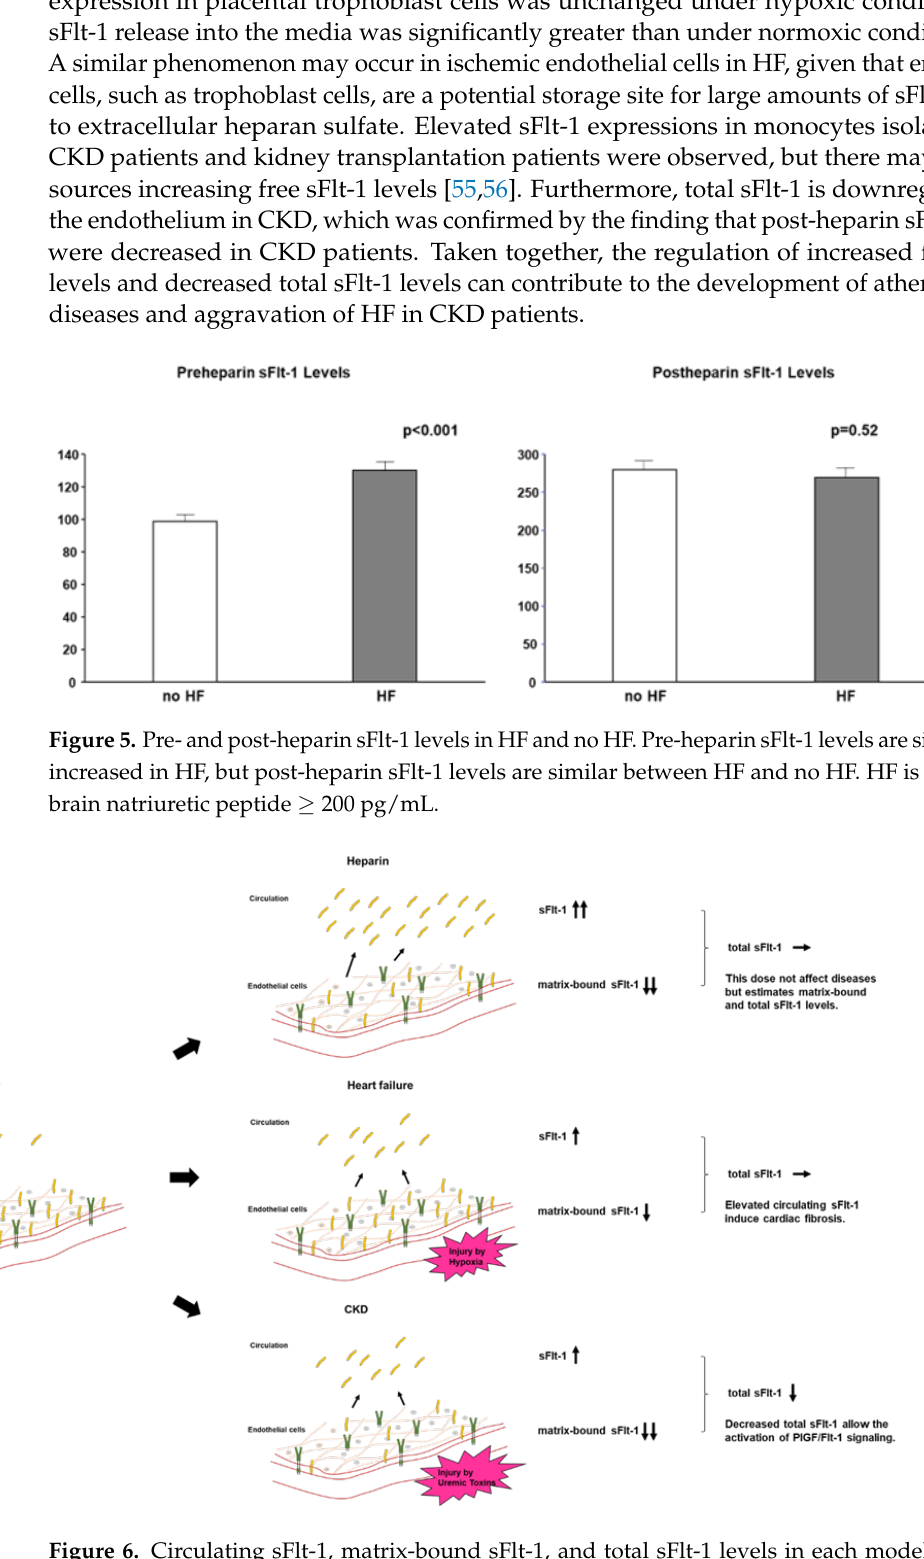
Figure 6. Circulating sFlt-1, matrix-bound sFlt-1, and total sFlt-1 levels in each model. Heparin infusion releases matrix-bound sFlt-1 into the circulation by displacing the sFlt-1 heparin-binding site from heparin sulfate proteoglycans. In HF, the release of free sFlt-1 from matrix-bound sFlt-1 under hypoxia may increase free sFlt-1 levels. Downregulated endothelial-derived sFlt-1 activates PlGF/Flt-1 signaling in CKD.